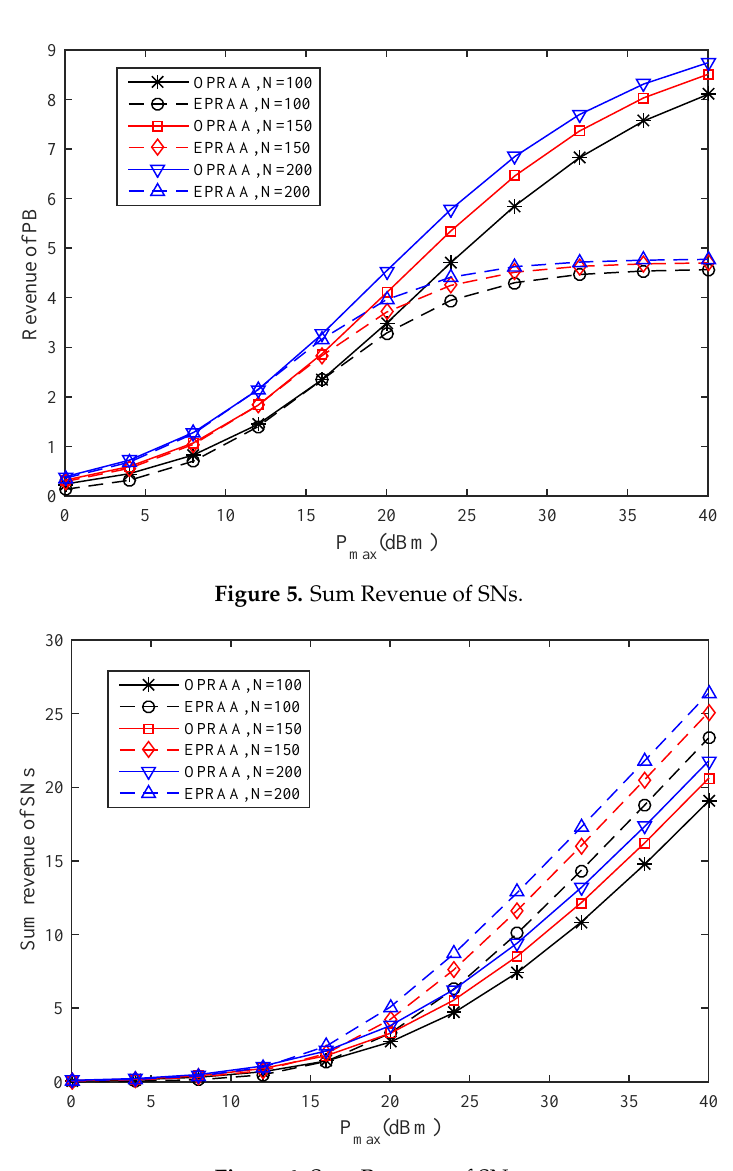
Figure 6. Sum Revenue of